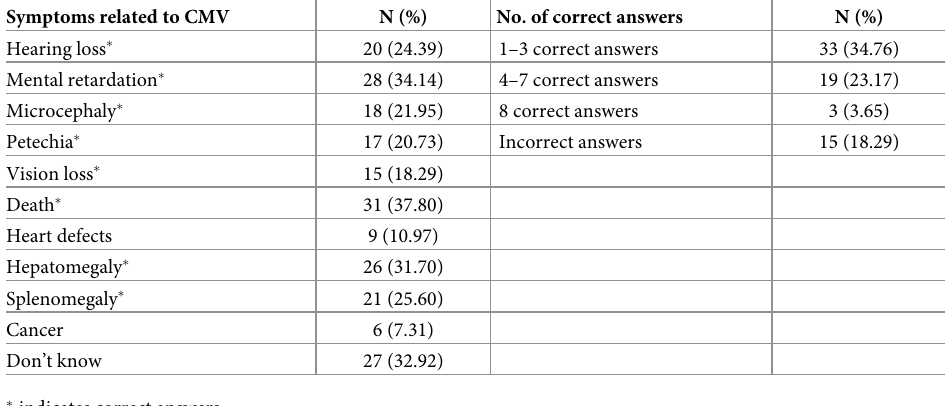
About one-quarter of respondents (n = 22, 26.82%) reported they were not aware of preventa- tive measures against CMV (Table 4). Table 3. Knowledge of symptoms of congenital CMV among survey respondents that previously heard of CMV. Symptoms related to CMV